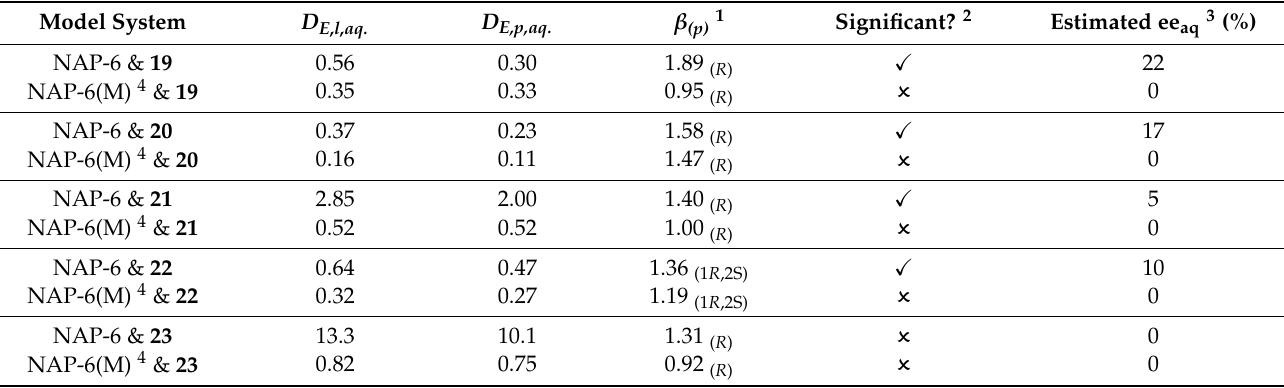
Table 2. Separability studies on the isolated, single enantiomers of the model compounds 19 – 23 using model systems containing CA-12, MEN-10 or DBTA-12 selector molecules (incubation = 60 min).